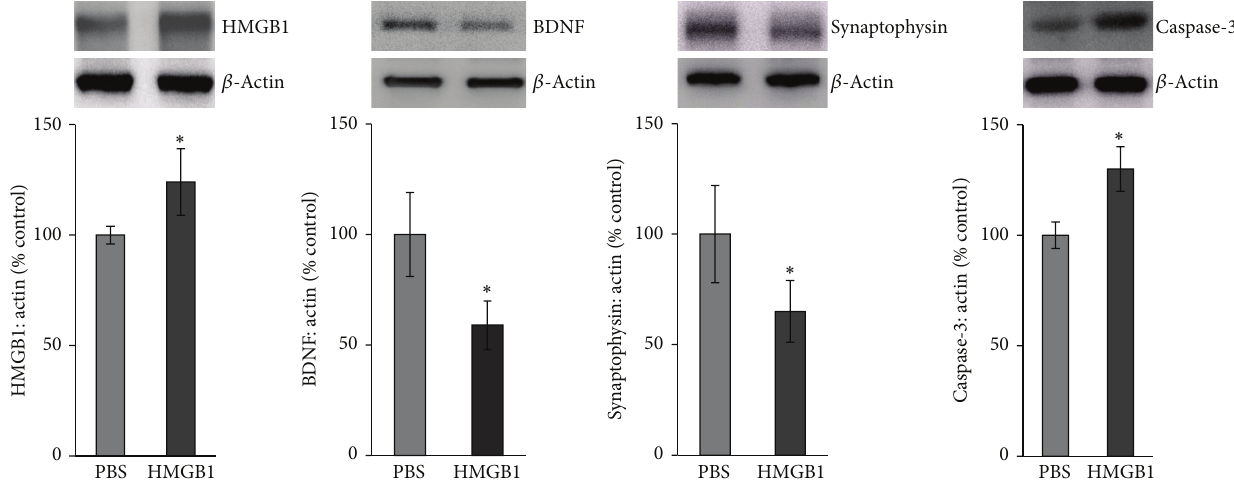
Figure 5: Western blot analysis of rat retinas. Intravitreal administration of high-mobility group box-1 (HMGB1) induced a significant upregulation of the expression of HMGB1 and cleaved caspase-3 and a significant downregulation of the expression of brain-derived neurotrophic factor (BDNF) and synaptophysin compared with intravitreal administration of phosphate buffer saline (PBS). Each experiment was repeated 2 to 3 times with fresh samples ( 𝑛 = 6